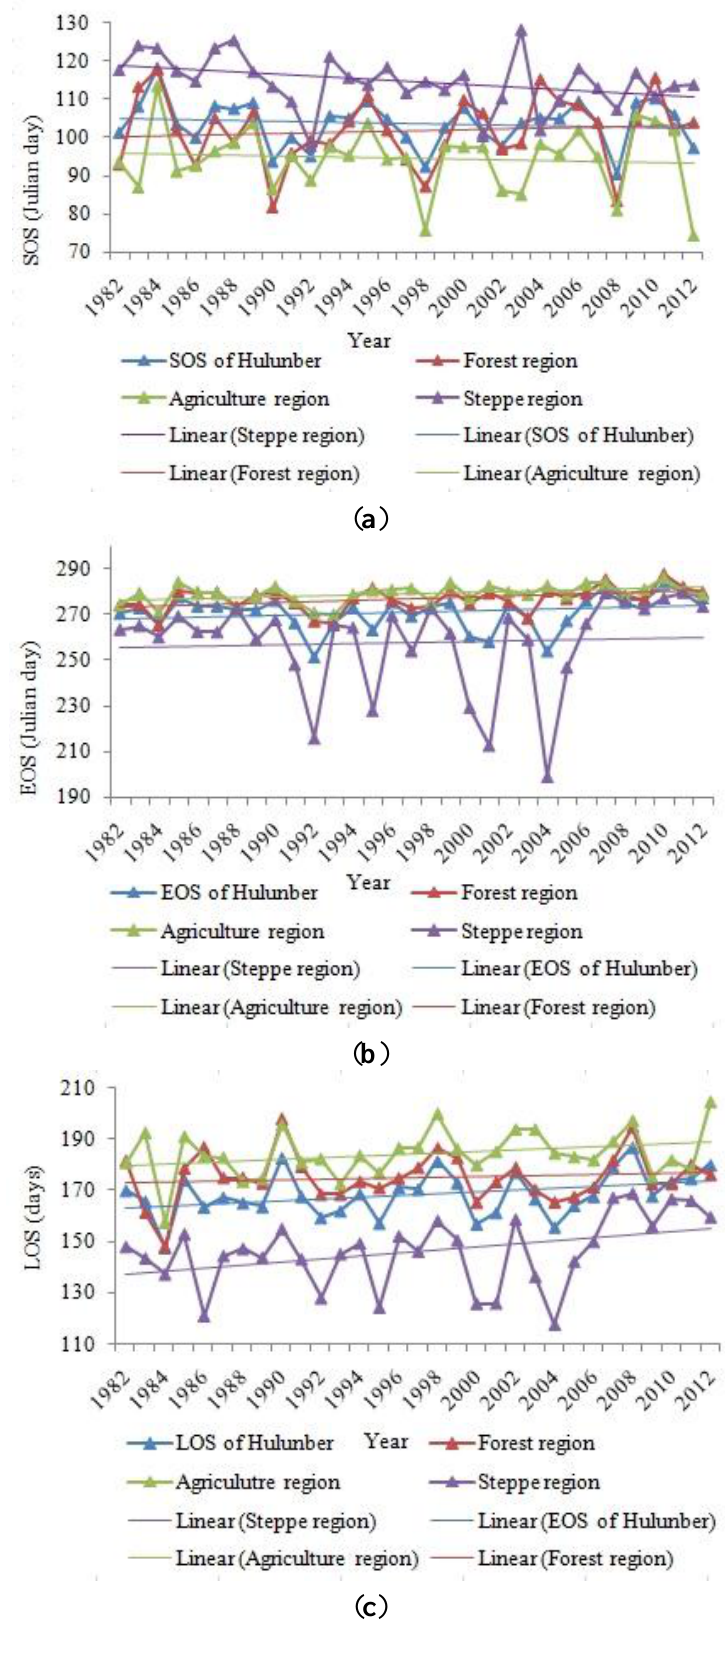
Figure 4. Interannual phenology variability in the growing season (April–October) for the three main regions and the entire Hulunber area from 1982 to 2012. ( a ) SOS; ( b ) EOS; ( c )